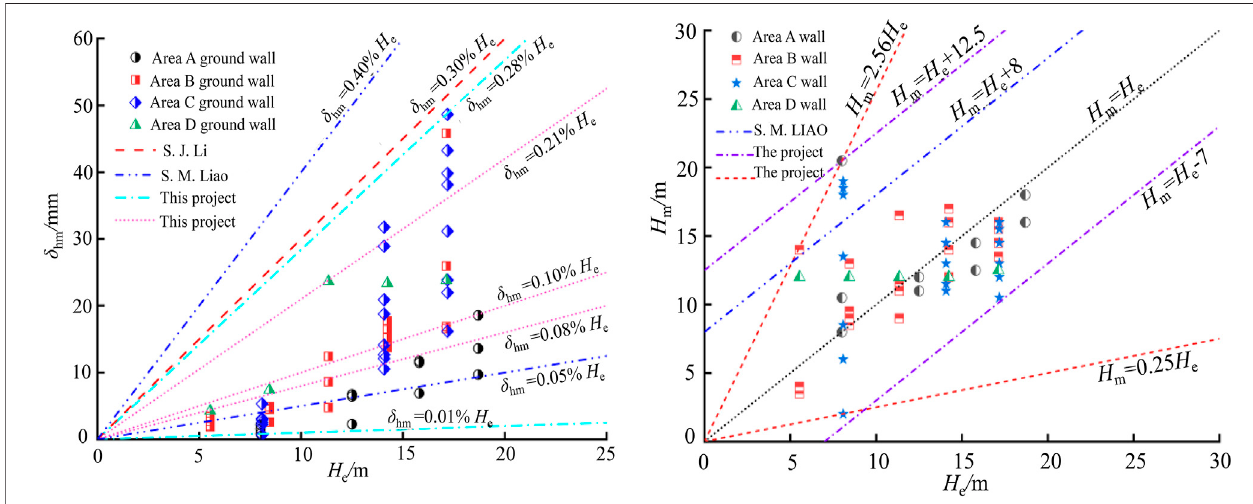
FIGURE4| Relationshipsbetween δ hm and H e andrelationshipsbetween H m and H e . (A) Relationshipsbetween δ hm and H e . (B) Relationshipsbetween H m and H e .